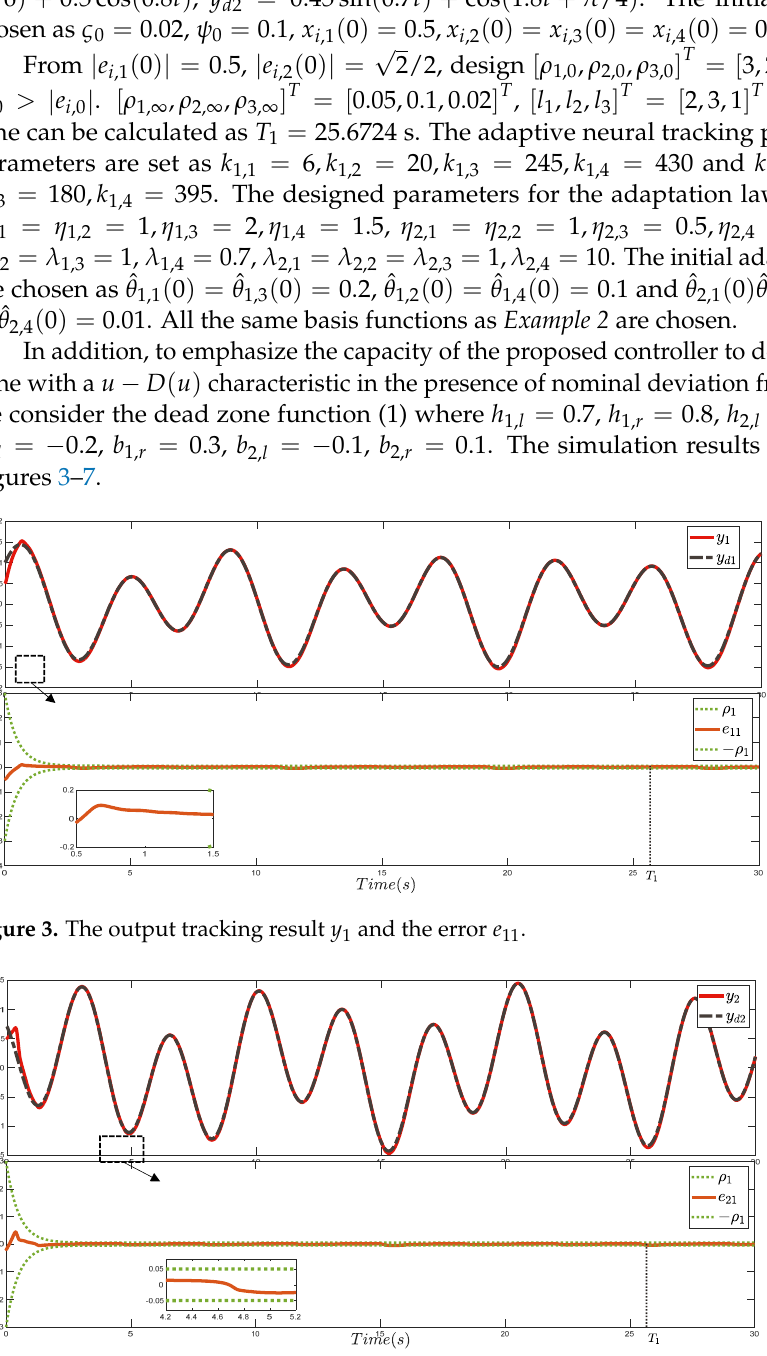
y and the error y and the error 2 2